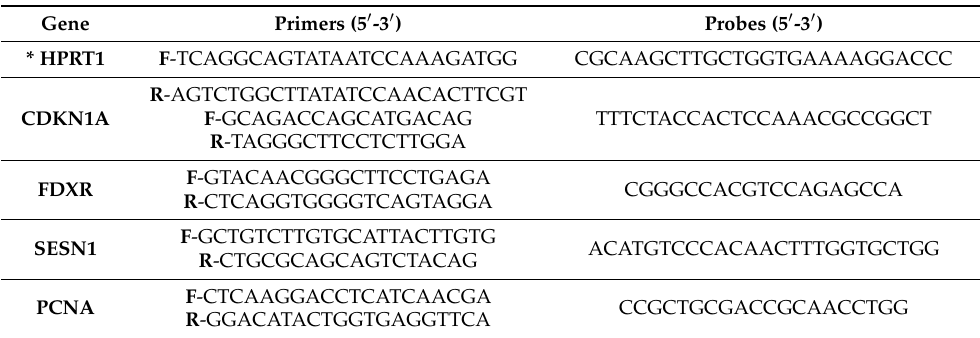
Table 2. Oligonucleotide primers and probes used for MQRT-PCR analysis. Primers designed by colleagues at Public Health England for biodosimetry studies